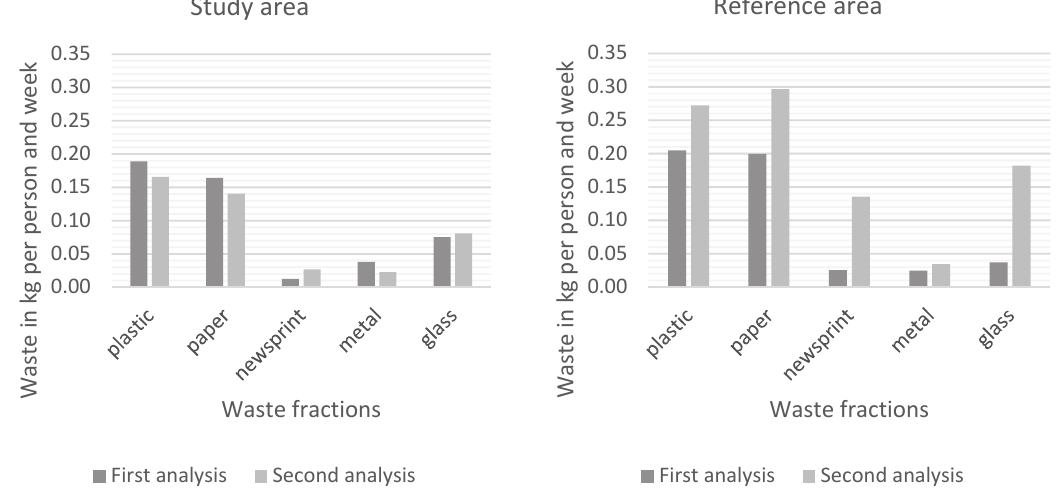
Figure 4. The mass of recyclables in white bags per person and week in the study area and the reference area. According to the local recycling scheme, there should not be any recyclable fractions in white bags.